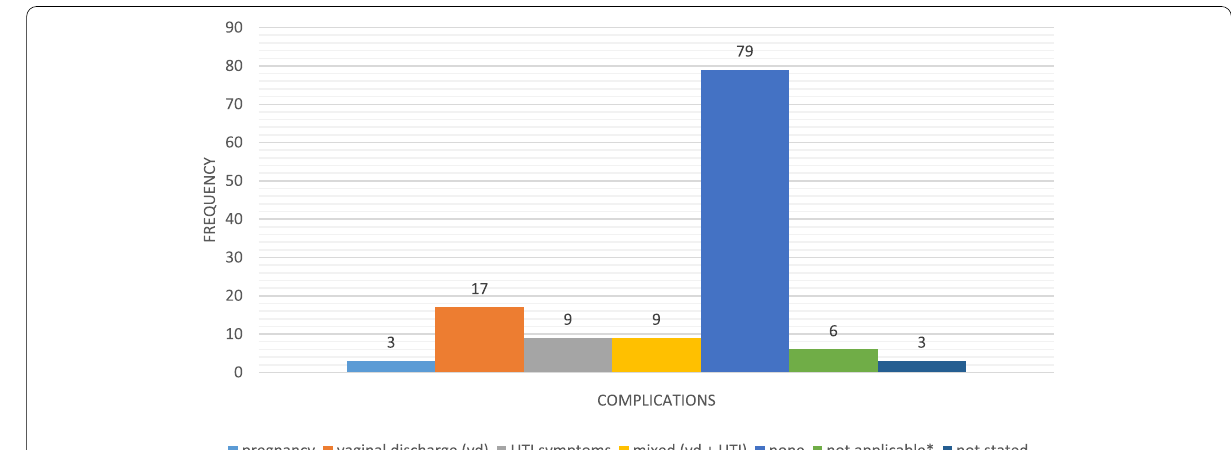
Fig. 2 Complications of CSA at